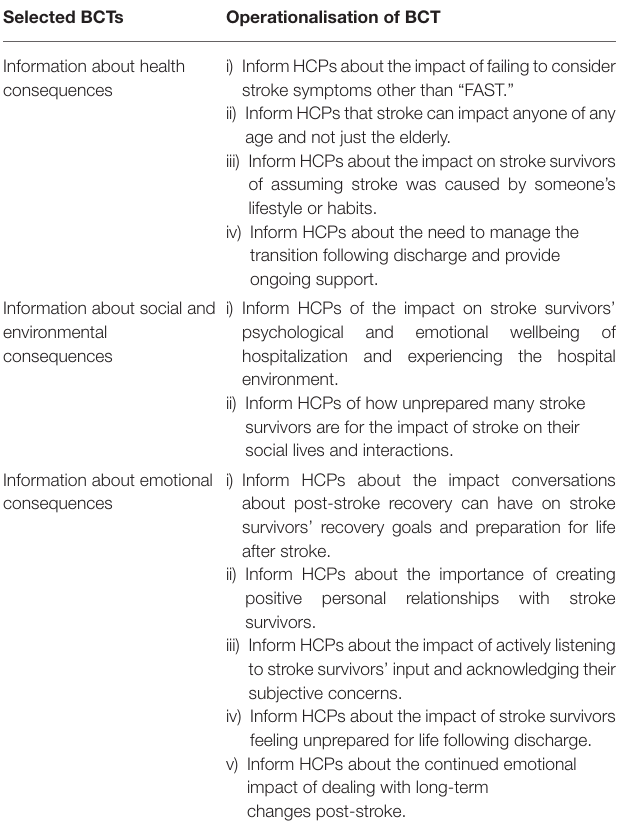
TABLE 6 | Selected BCTs and operationalisation in designed intervention (BCW Step 7).